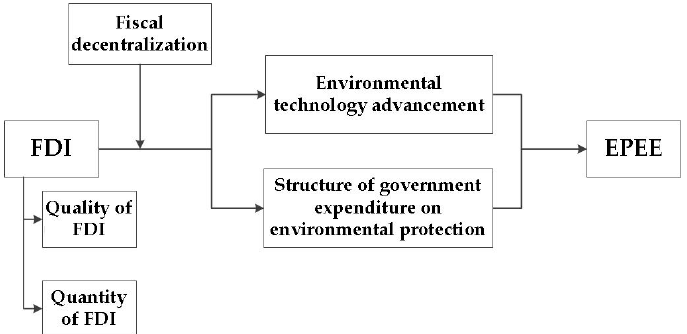
Figure 1. Foreign direct investment (FDI), fiscal decentralization and the efficiency of government expenditure on environmental protection (EPEE) logic diagram.